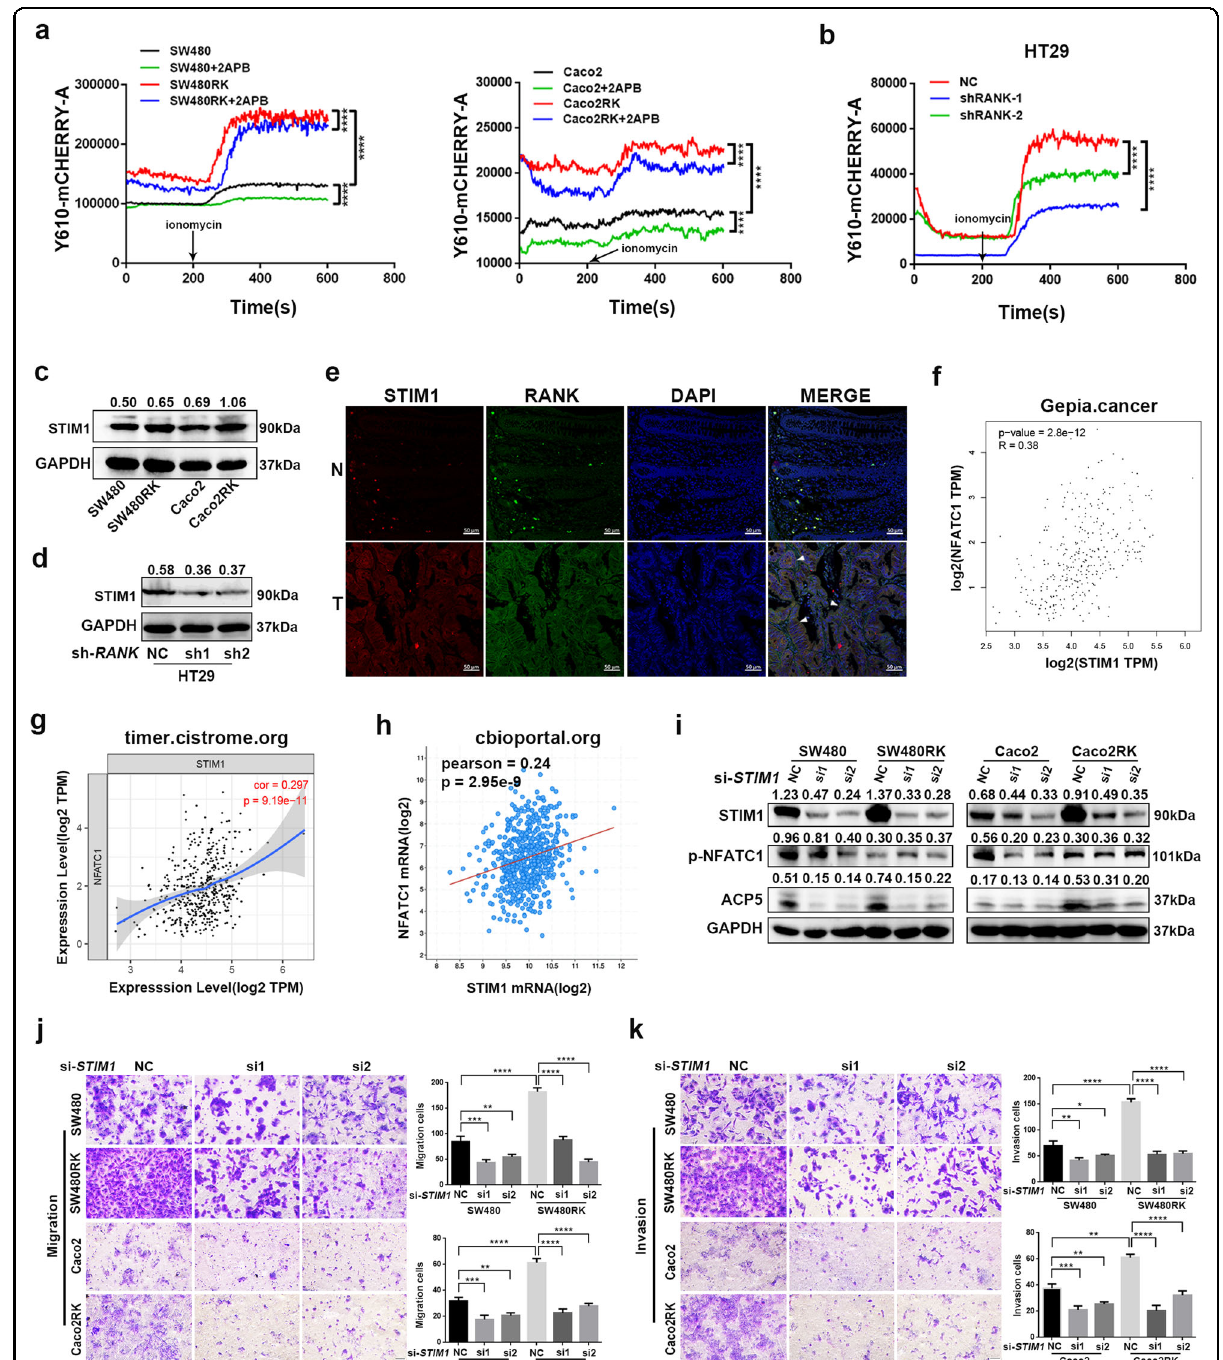
Fig. 6 RANK activated calcineurin/NFATC1 axis by STIM1-mediated Ca 2 + in fl ux. a , b The calcium- fl ux analysis in response to ionomycin in CRC cells with RANK overexpression or knockdown. Besides, the effect of 100 μ M 2APB on RANK -overexpressing SW480 and Caco2 cells were analyzed. c , d Western blotting showed that STIM1 protein levels were regulated by RANK in CRC cells. e STIM1 was co-stained with RANK in CRC tissue and paired normal colon tissues by immuno fl uorescence. The white arrowheads indicate that the overlap of RANK-positive cells and STIM1-positive CRC tissues. DAPI staining for nuclei. Scales bars = 50 μ m. T human CRC tissues, N paired normal colorectal tissues. f – h The mRNA levels of STIM1 were positively correlated with NFATC1 in CRC assessed by online databases. i Silence of STIM1 reversed RANK-induced ACP5 expression activation and increased phosphorylated NFATC1. j , k Silence of STIM1 rescued the migration and invasion of RANK -overexpressing SW480 and Caco2 cells. Scales bars = 100 μ m. Data are mean ± SD ( n = 3). ** P < 0.01, *** P < 0.001, **** P <